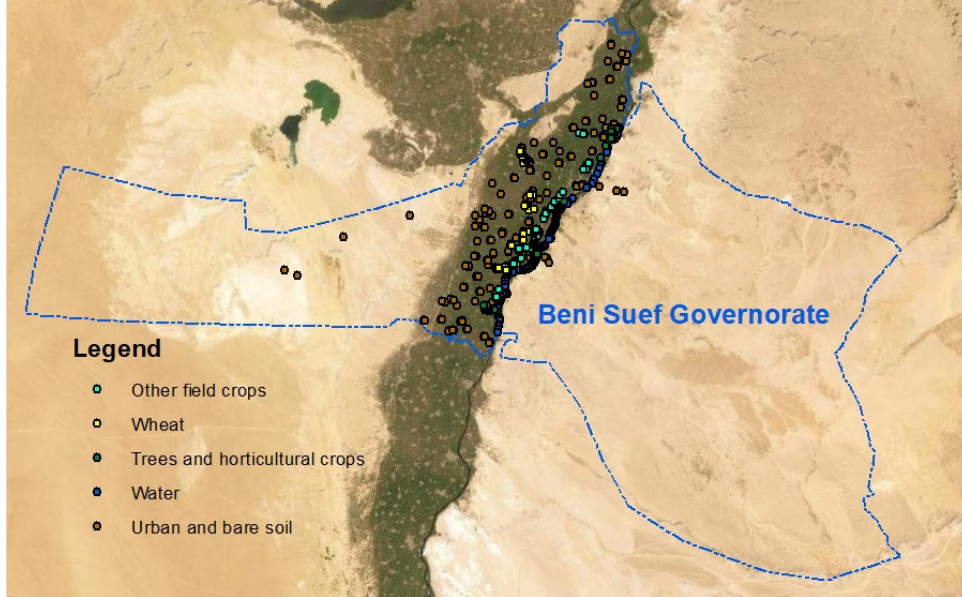
Figure 3. Spatial distribution of the ground-truthing of the winter field crops and non-field crops (urban, bare soil, water, horticultural crops, and natural vegetation).